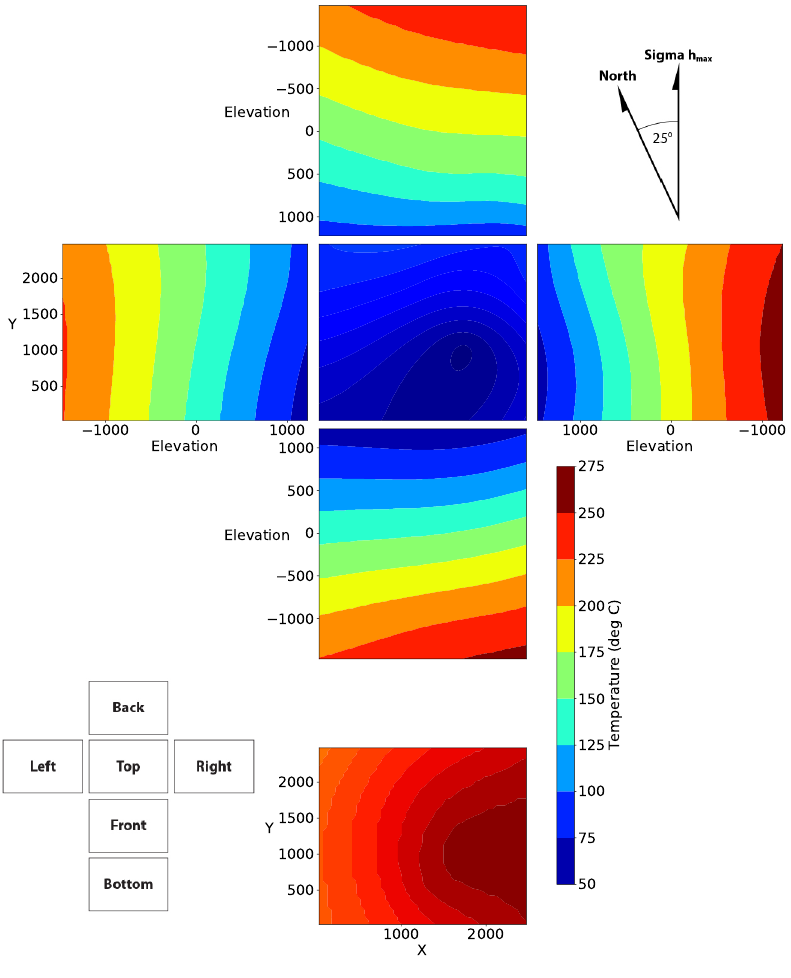
Figure 9. Temperature boundary